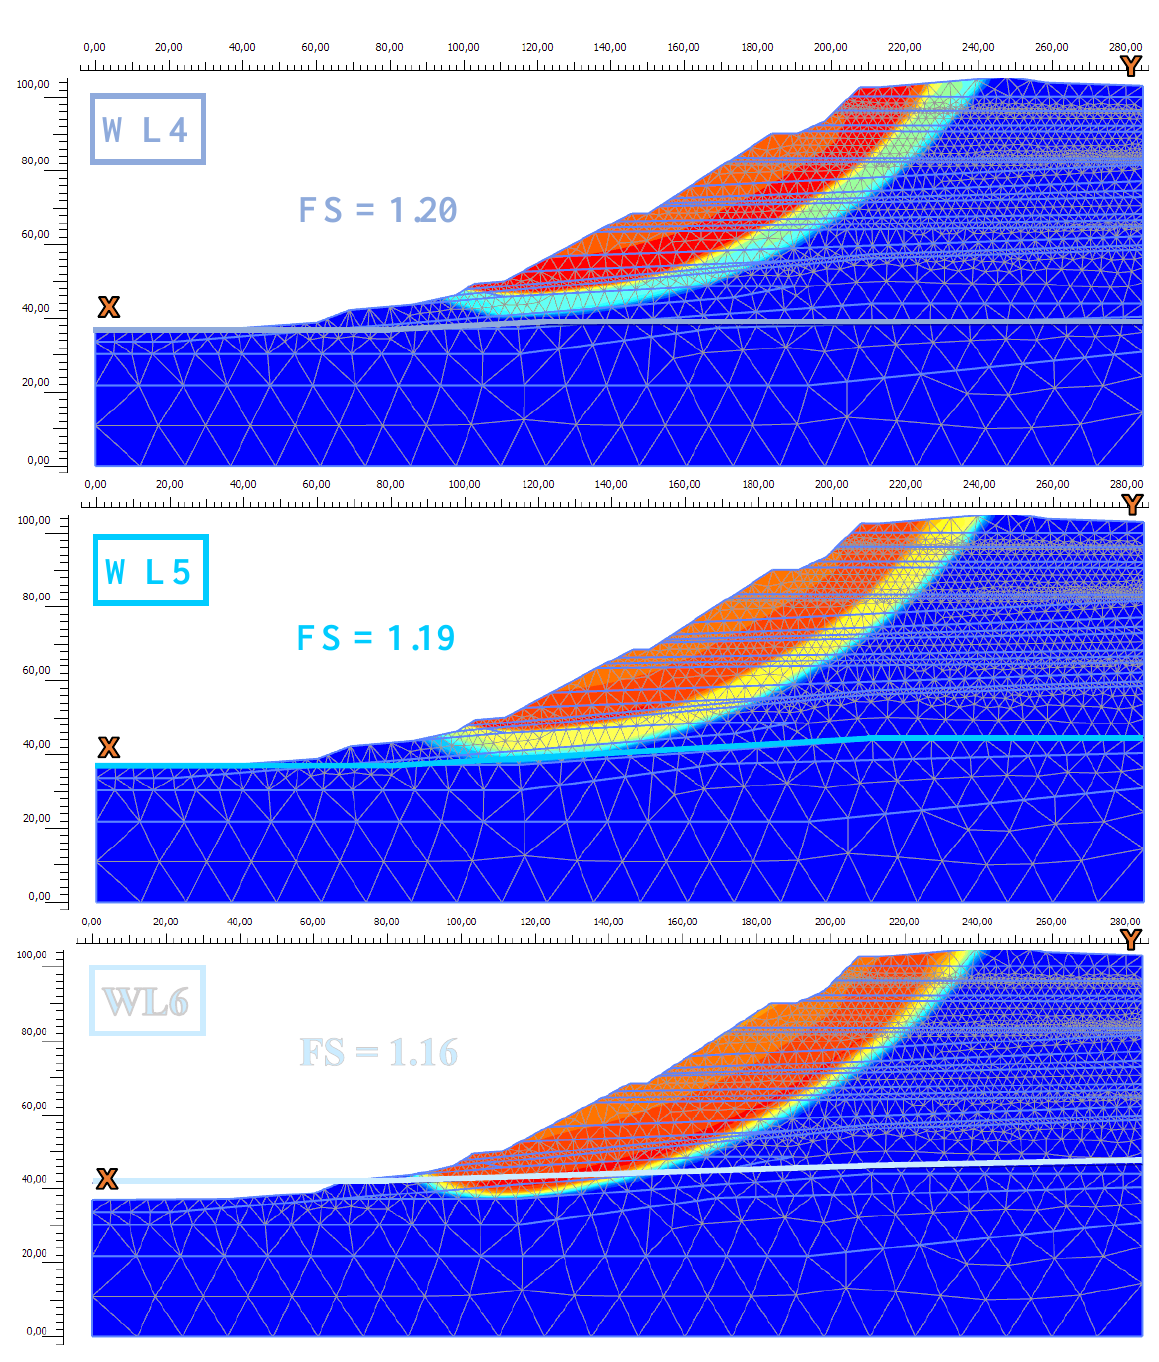
Figure 13. Results of Plaxis software: shape of failure mechanism and safety factor for three different modeled water levels (WL4: maximum values of water levels measured in 2020; WL5: maximum lake-water level ever and congested waters; WL6: extra high water level